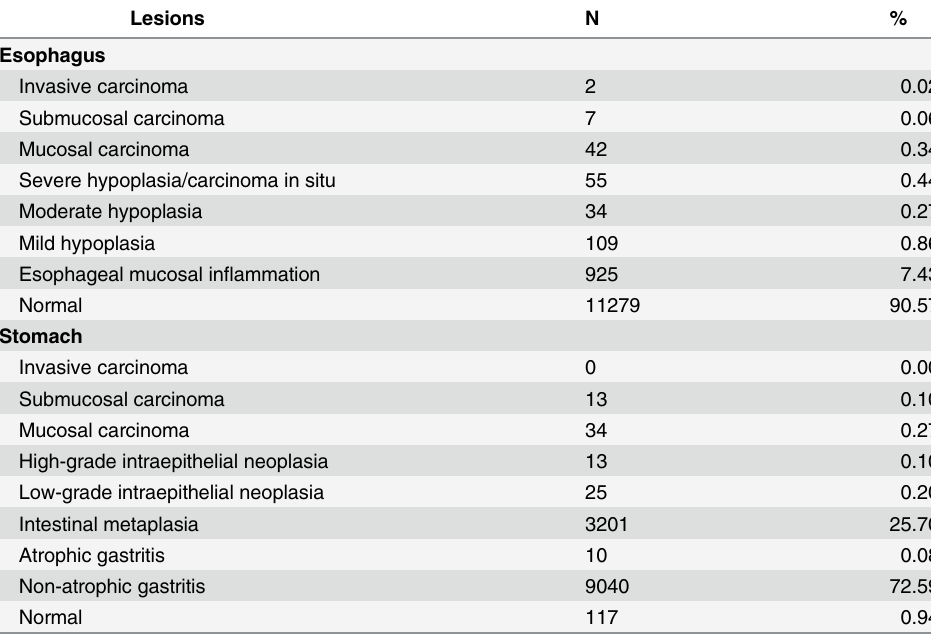
Table 2. Endoscopic findings for the esophagus and stomach.